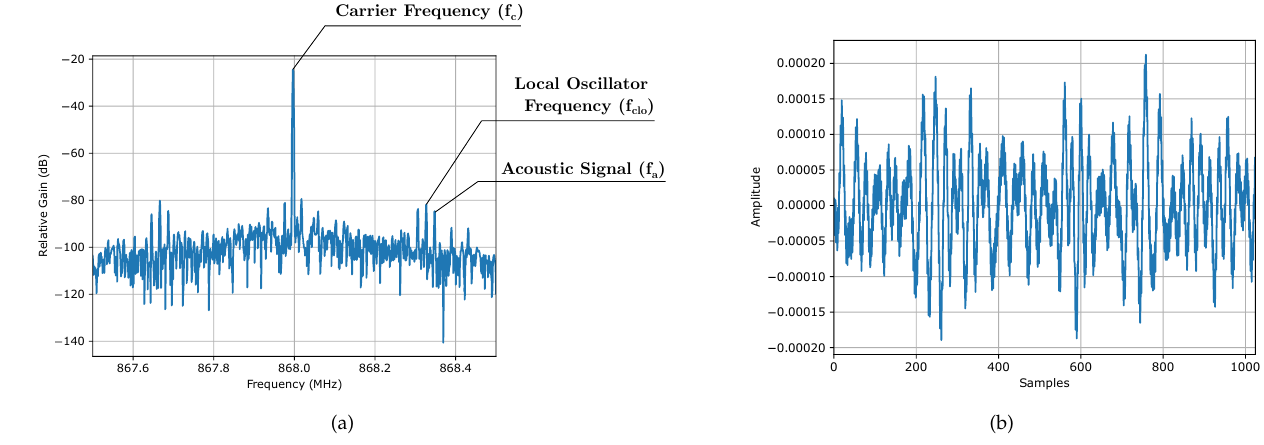
Figure 8. ( a ) Spectrum of the received backscattered signal, showing the two symmetric sidebands with the RF carrier frequency at the center; and ( b ) 1ms of samples from the received backscattered signal in the time domain before the cross-correlation ( ∆ x a =